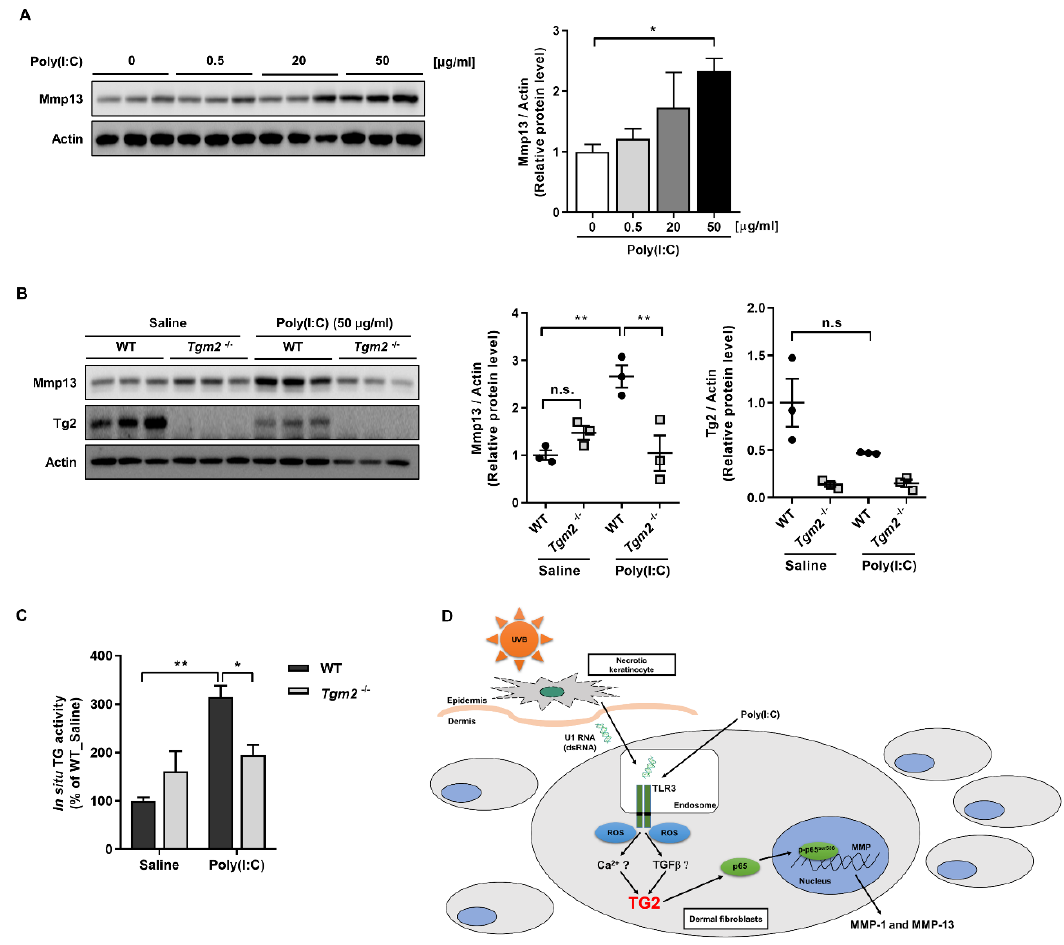
Figure 6. Ex vivo-cultured Tgm2 − / − mouse skin shows reduced Mmp13 expression in response to poly(I:C) treatment. ( A , B ) Skin explants were prepared from wild-type and Tgm2 − / − neonatal mice treated with various doses ( A ) or 50 µg/mL ( B ) of poly(I:C) for 24 h. Total skin extracts were immunoblotted with anti-Mmp13 antibody (left, n = 3). The ratio of Mmp13 or Tg2 to Actin was estimated by densitometric analysis of Western blot (right). ( C ) Effect of poly(I:C) treatment (50 µ g/mL for 9 h) on in situ TG activity in wild-type and Tgm2 − / − mouse skin explants. Intracellular TG activity was assessed by BP incorporation assay. ( n = 3) ( D ) A schematic representation of poly(I:C)-induced MMPs expression through TG2 activation. All data are represented as mean ± SEM. Statistical significance was tested by one-way ANOVA by Dunnett’s post-test ( A ) or two-way ANOVA by Turkey’s post-test ( B , C ). * , p < 0.05; ** , p < 0.01; n.s., not